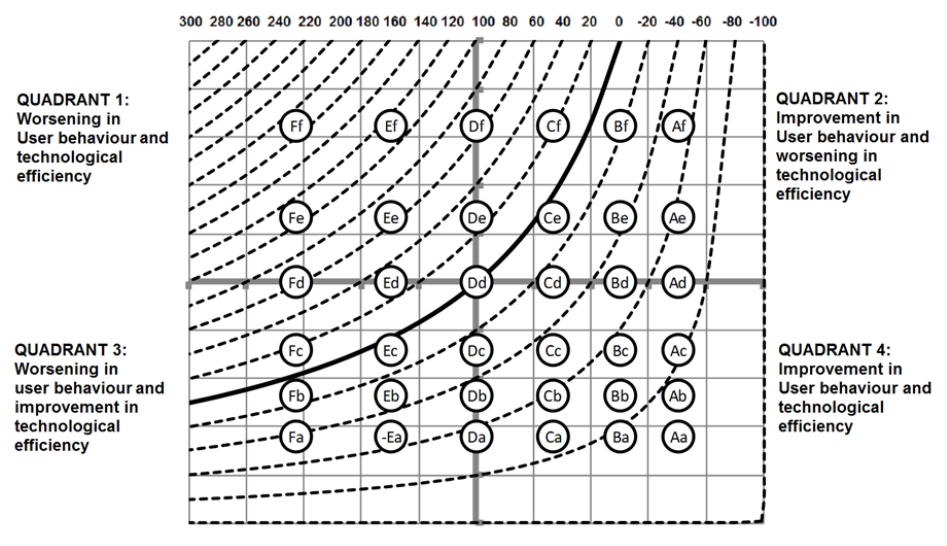
Figure 6. Office demands through behavioural and technological changes (Futures Framework approach, contours at 20% intervals).